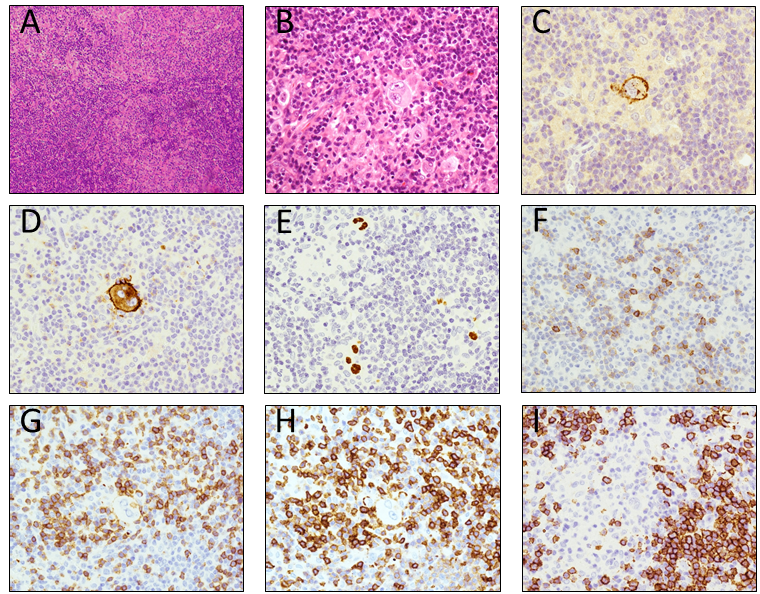
Figure 1. The pathologic examination of the axillary lymph node. ( A ) Hodgkin/Reed ‐ Sternberg (HRS) cells with typical morphologic structure surrounded by small lymphocytes in the background of scattered small atypical lymphocytes: H ‐ E staining, ×100 (A); H ‐ E staining, ×400; ( B ) the HRS cells were positive for CD15 ( C ), CD30 ( D ), Epstein–Barr virus (EBER) ( E ). The small lymphocytes around the HRS cells were positive for CD2 ( F ), CD3 ( G ), CD5 ( H ). The background scattered atypical small lymphocytes were positive for CD5 ( H ), CD20 ( I ).